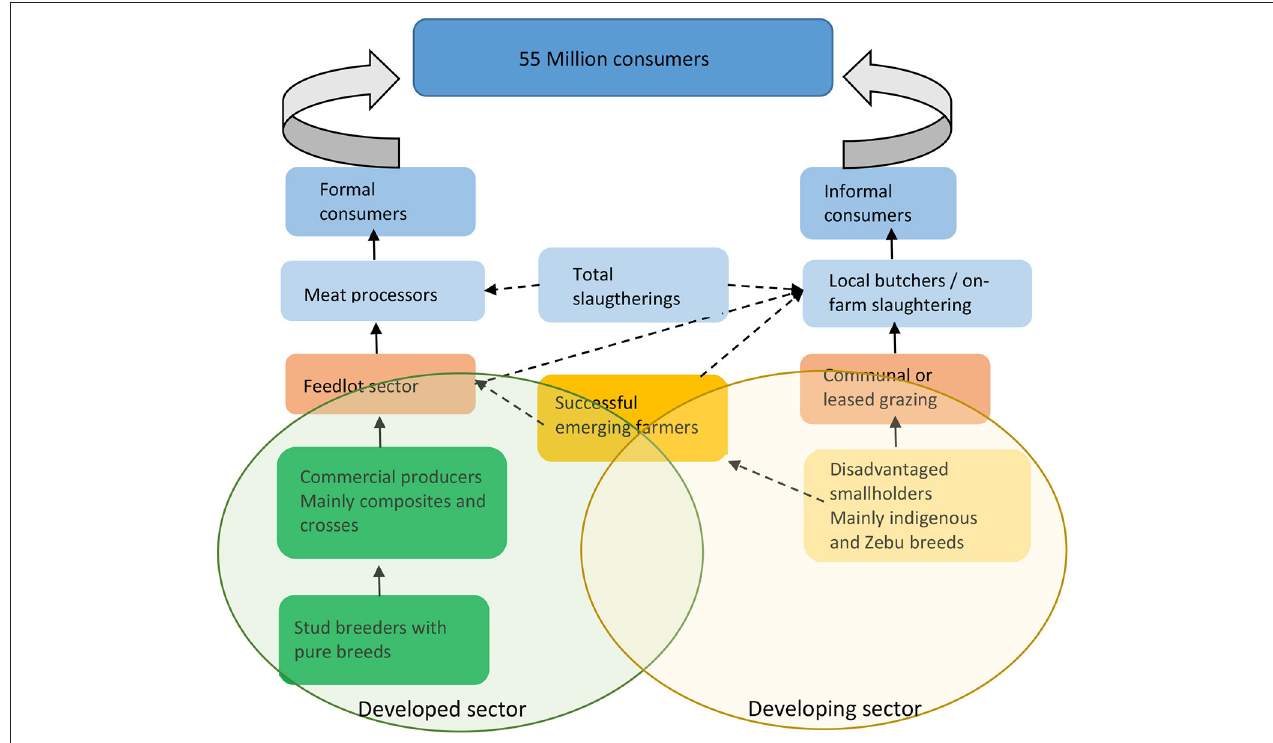
FIGURE 1 | The value chains for the developed vs. developing beef sectors in South Africa (Adapted from http://www.rmrdsa.co.za/REDMEATINDUSTRY/ Valuechains.aspx).